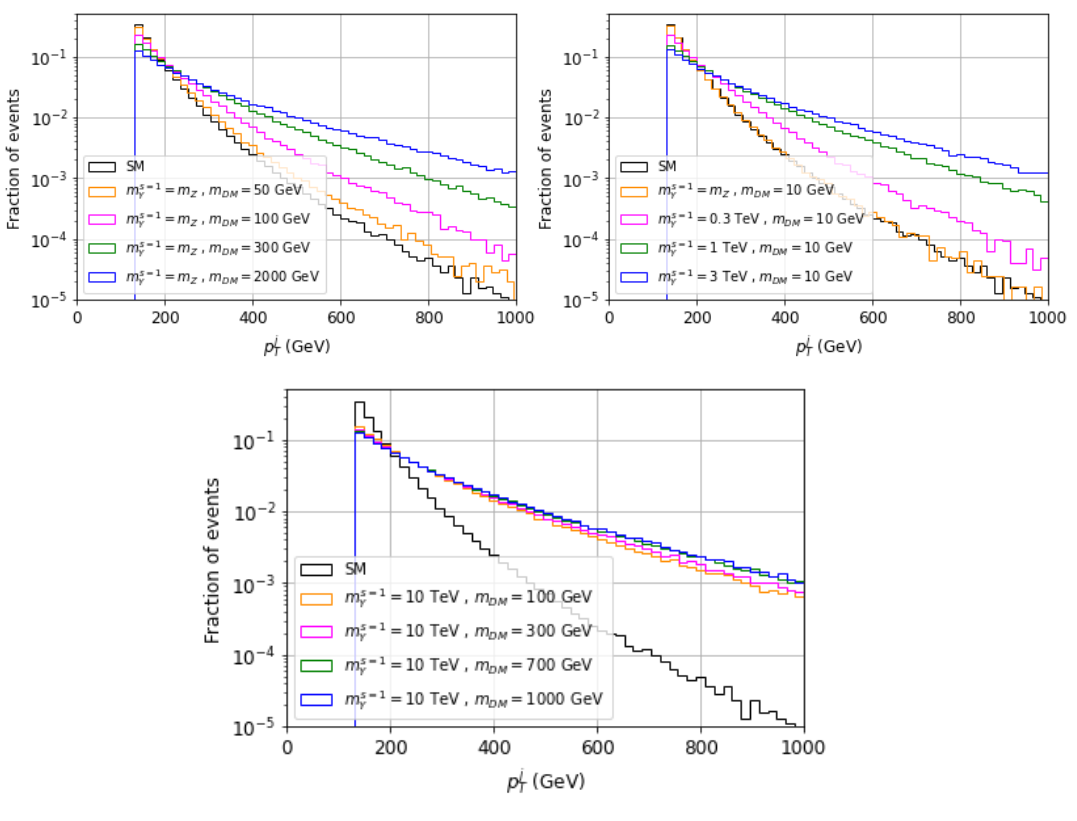
distributions of the spin-1 mediator framework, off-shell (top-left panel), Figure 3: p j T on-shell (top-right panel), and off-shell PS (bottom panel) regimes, at parton